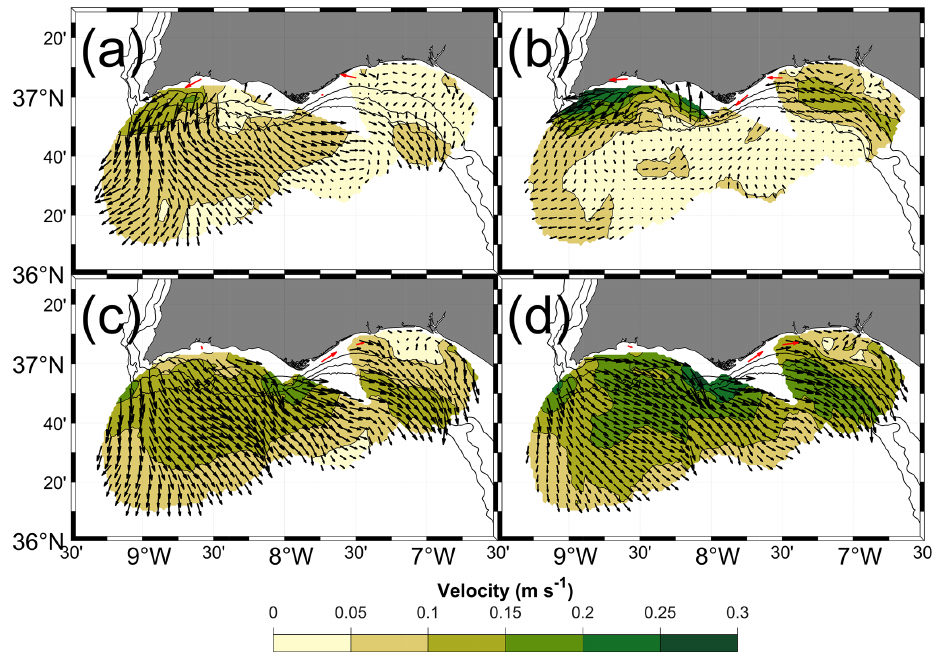
Figure 13. Conditioned mean map computed from periods when the alongshore velocity at W2 was between 0.05 and 0.1ms − 1 (a, c) and for periods with velocities > 0.1ms − 1 (b, d) . Panels (a) and (b) represent PFs ( c, d represent EFs). Red arrows indicate the mean velocity computed from available ADCP data for the same periods. For clarity, arrows are represented every four grid